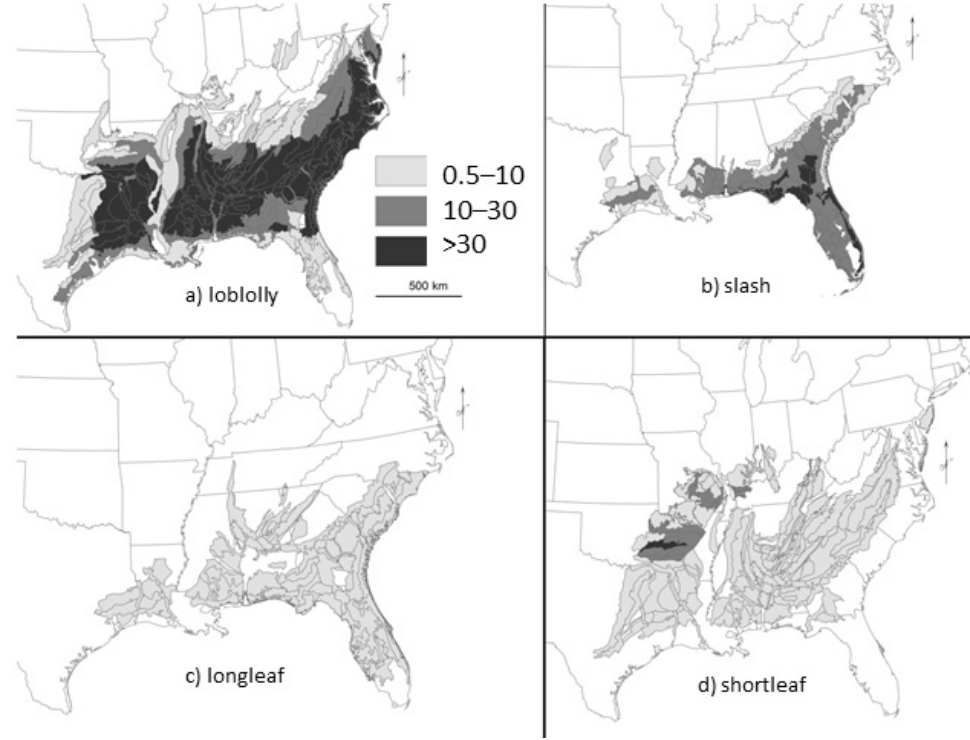
Figure 4. Current ranges (percent composition ≥ 0.5% of all trees in an ecological subsection, which are shaded) and three groupings of abundance by percent composition in ecological subsections for the four pine species.